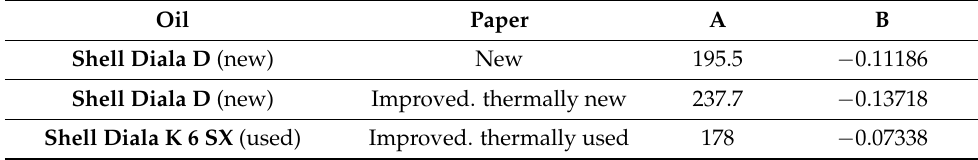
Table 13. Parameters to be used in Equation